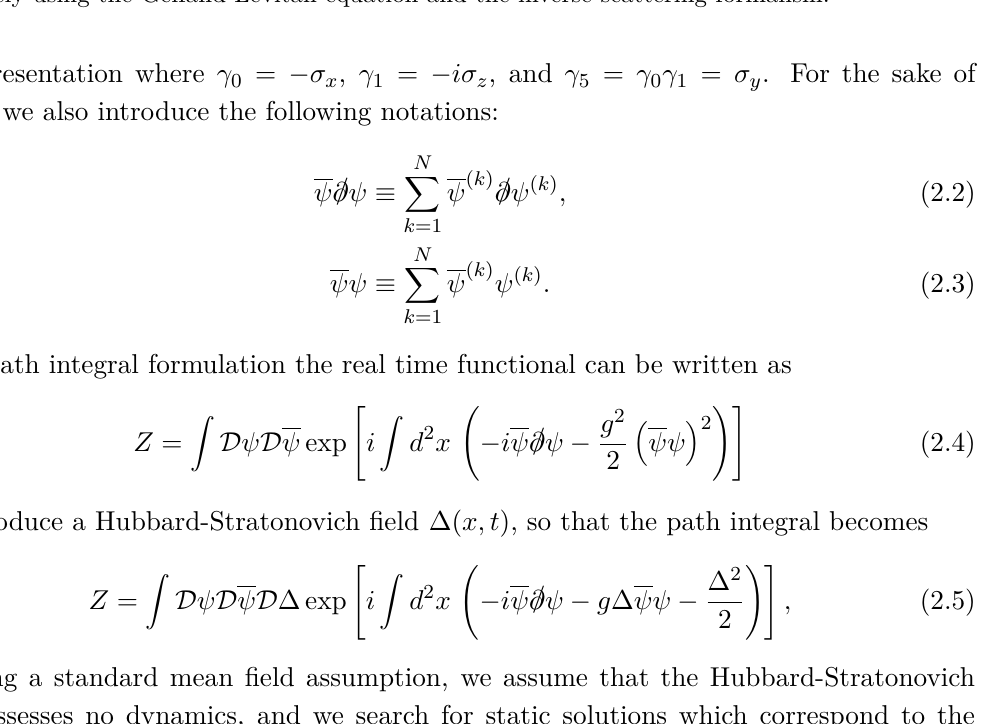
the representation where γ